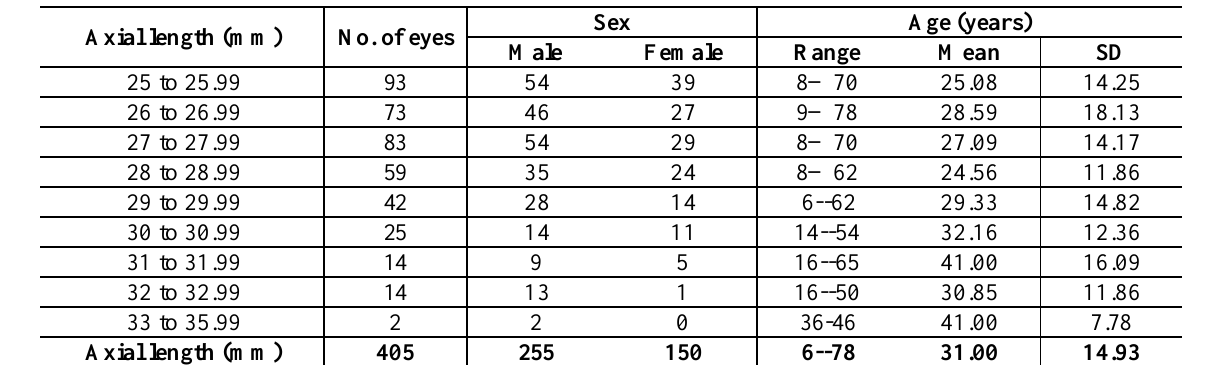
Table I : Distribution of Study Population